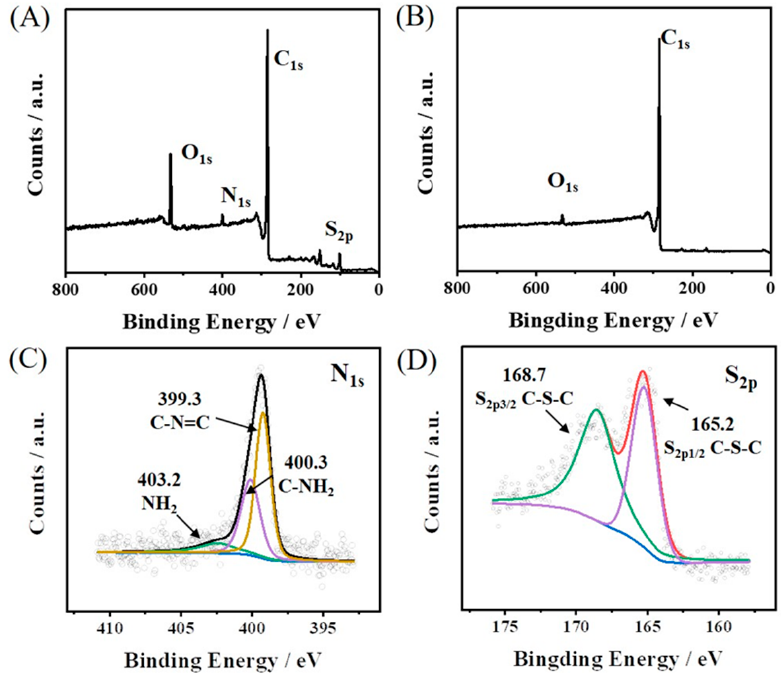
Figure 2. Survey XPS spectra of ( A ) THI-rGO and ( B ) rGO. High-resolution ( C ) N 1s and ( D ) S 2p XPS spectra of THI-rGO.